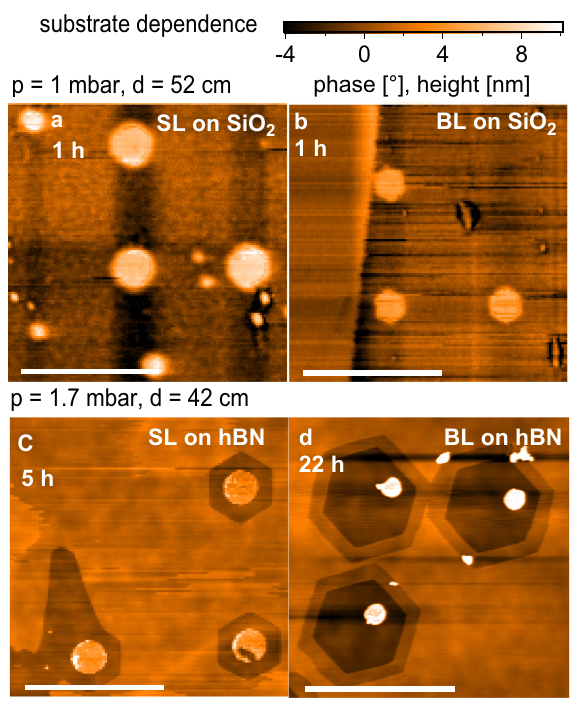
Fig. 3 Substrate dependence of SL/BL graphene. a , b AFM phase contrast images of a SL ( a ) and BL ( b ) section of the same fl ake on a SiO 2 substrate, etched for 1 h at T = 450 °C. Round holes of 50 nm diameter were de fi ned before H-etching. AFM topography image of a SL ( c ) and BL ( d ) fl ake on hBN etched for 5 h and 22 h, respectively. Holes of 200 nm (SL) and 100 nm (BL) were de fi ned before etching. For d the color scale values are divided by four. The scale bars on all images are 1 μ